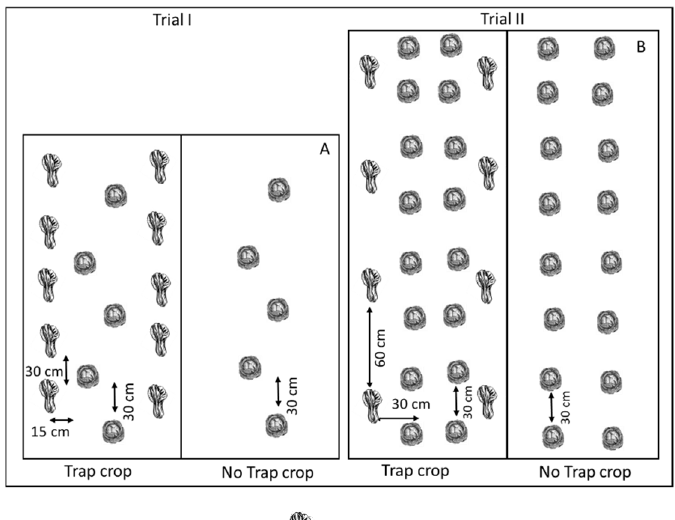
Figure 1. Kai choi trap crops Figure 1. Kai choi trap crops around head cabbage in ( A ) Trial I and ( B ) Trial II. around head cabbage Figure 1. Kai choi trap crops around head cabbage in ( A ) Trial I and ( B ) Trial II. in ( A ) Trial I and ( B ) Trial II. Figure 1. Kai choi trap crops around head cabbage in ( A ) Trial I and ( B ) Trial II.